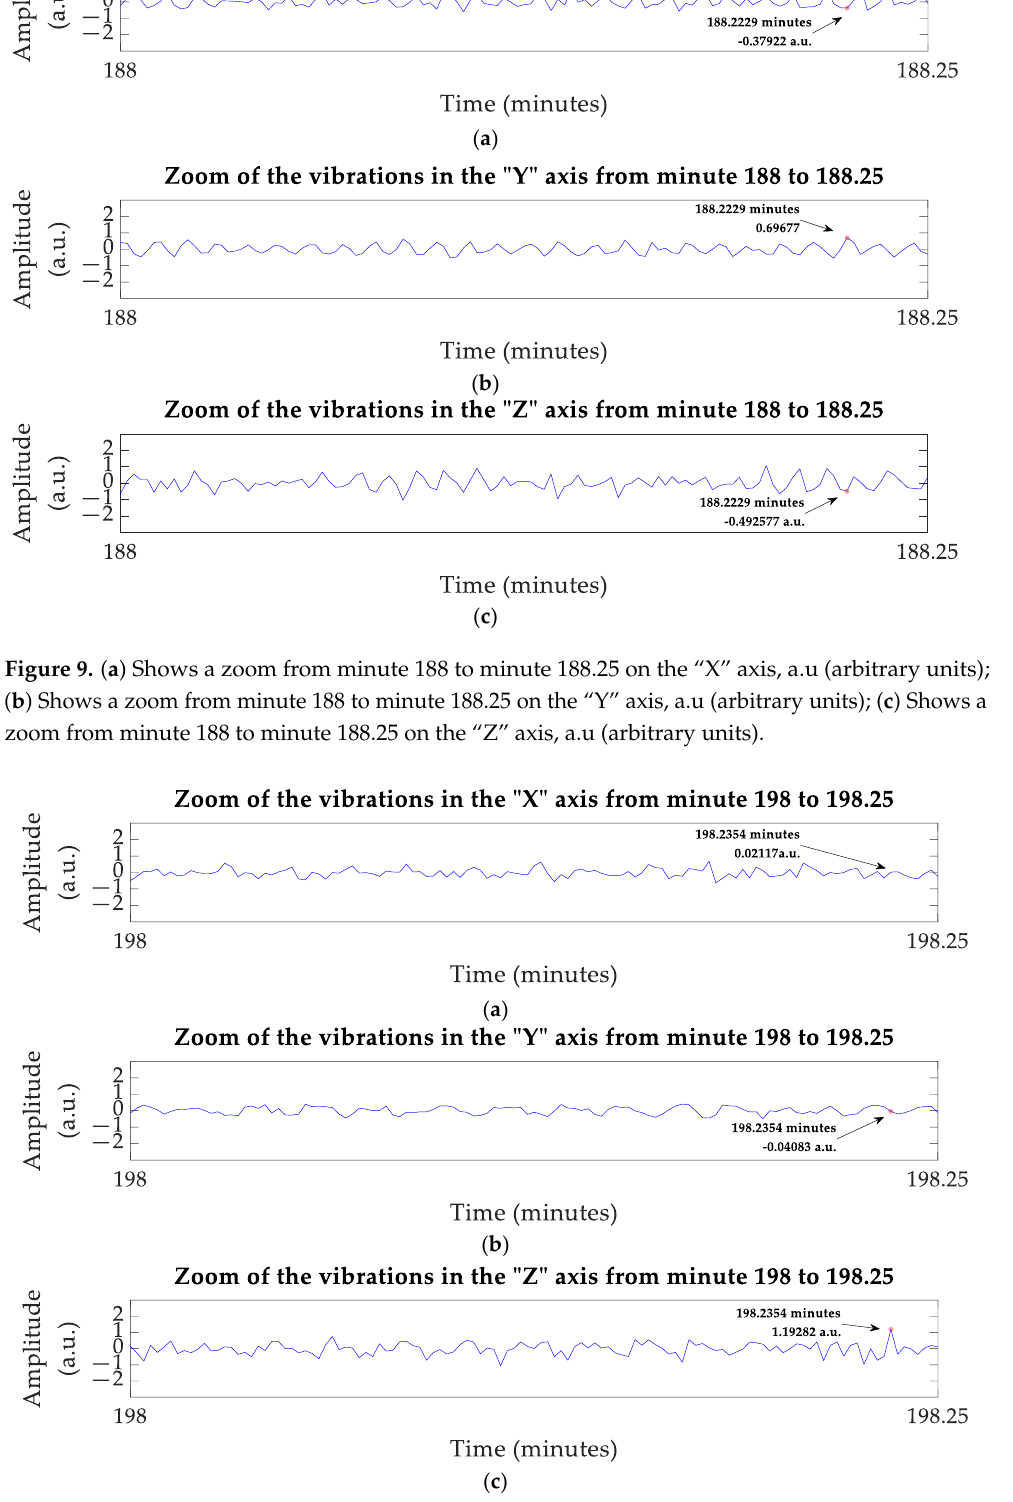
Figure 10. ( a ) Shows a zoom from minute 198 to minute 198.25 on the “ X ” axis, a.u (arbitrary units); ( b ) Shows a zoom from minute 198 to minute 198.25 on the “ Y ” axis, a.u (arbitrary units); ( c ) Shows a zoom from minute 198 to minute 198.25 on the “ Z ” axis, a.u (arbitrary units). Figure 11 shows a graph with the “ X ” , “ Y ” and “ Z ” axes joined, showing the increase